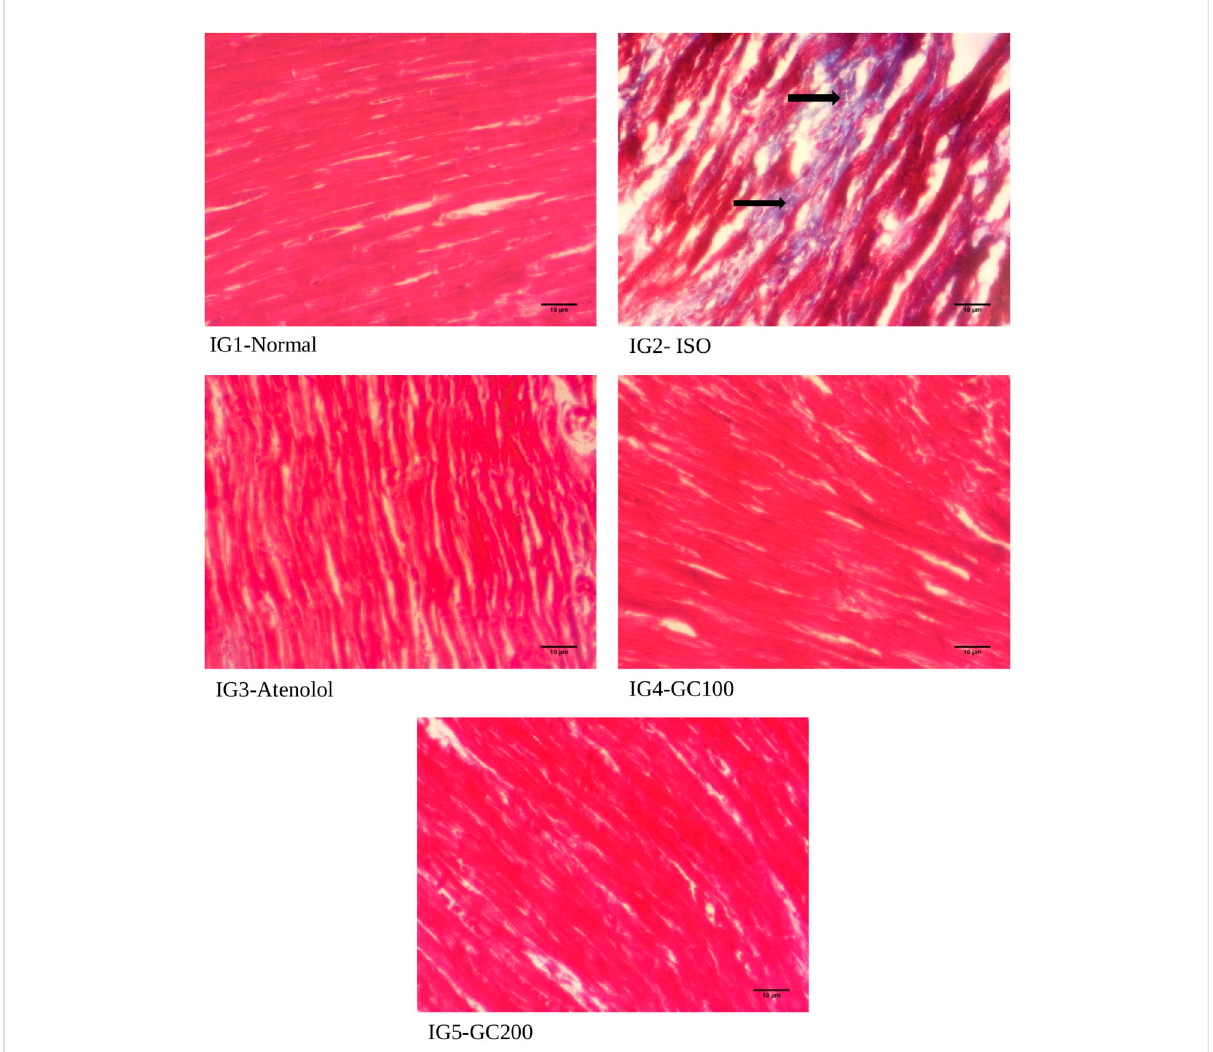
FIGURE 11 Histopathological analysis of Masson trichome staining- a comparison with the normal, ISO treated and GC- pre- treatment experimental groups. Scale bar- 10 μ m, Magni fi cation ×400. (Blue stained areas marked with black arrows show collagen deposition, an indication of interstitial fi